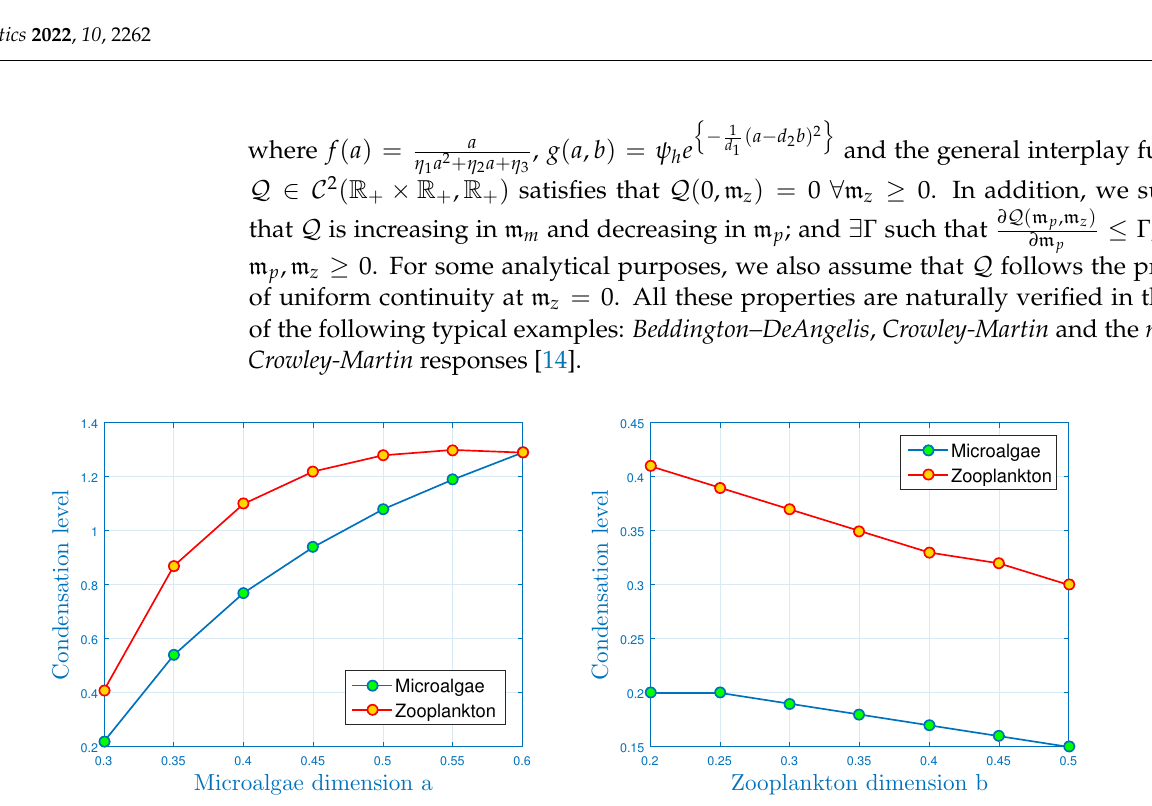
Figure 3. Some statistics on the relationship between cell and body dimensions of phytoplankton and zooplankton on plankton environment